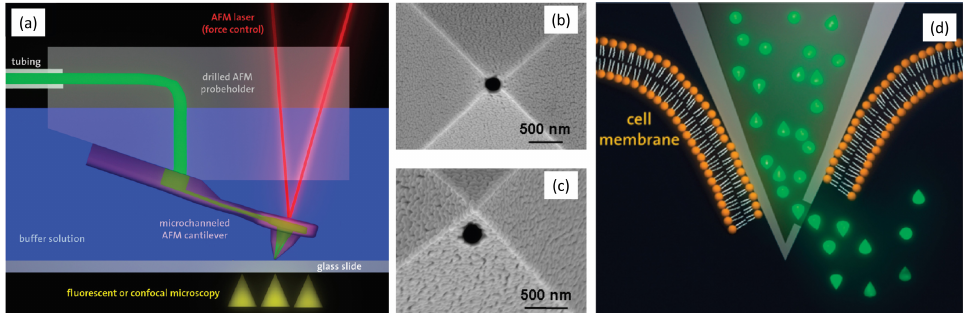
Figure 7. FluidFM principle illustration: ( a ) schematic diagram of a hollow cantilever with mi- crofluidic channels, ( b , c ) SEM image of a FluidFM probe tip with openings on the tip apex for cell manipulation and near the tip apex for particle injection and sampling, and ( d ) schematic of an injection process of particles into cells after penetrating the membrane (adapted with permission from [121], copyright 2009 American Chemical